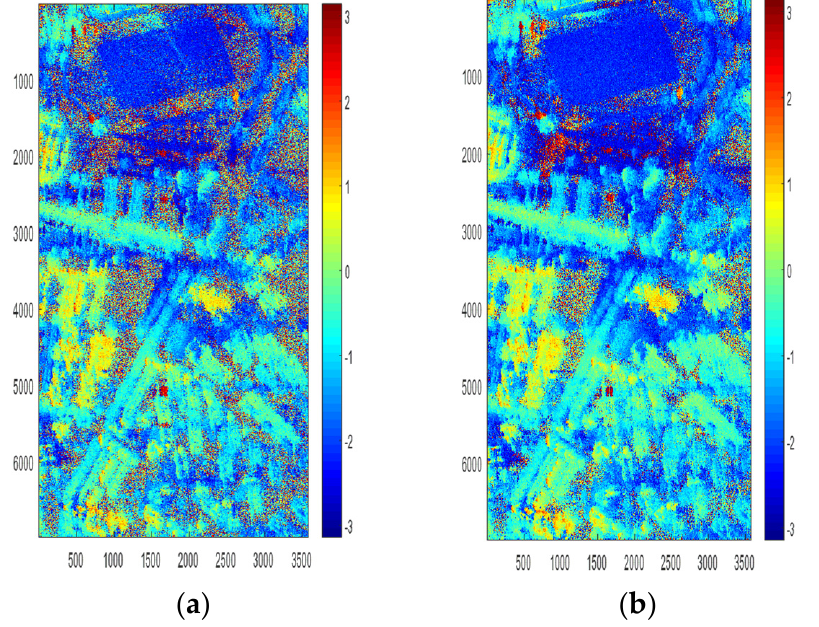
Figure 7. Interferometric phase. ( a ) Interferometric phase of single scattering. ( b ) Interferometric phase of polarimetric interferometric optimal decomposition. The height inversion results with a mask are shown in Figures 8 and 9a.